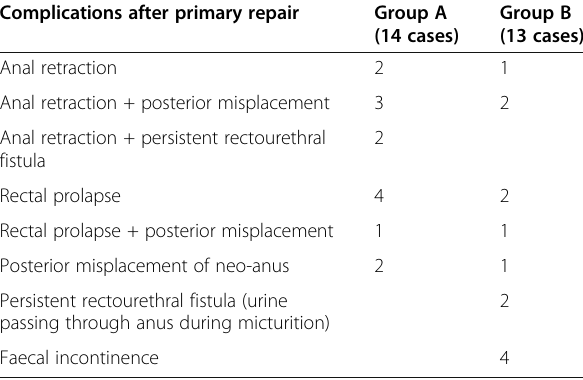
Table 1 Indications for reoperation in both study groups Complications after primary